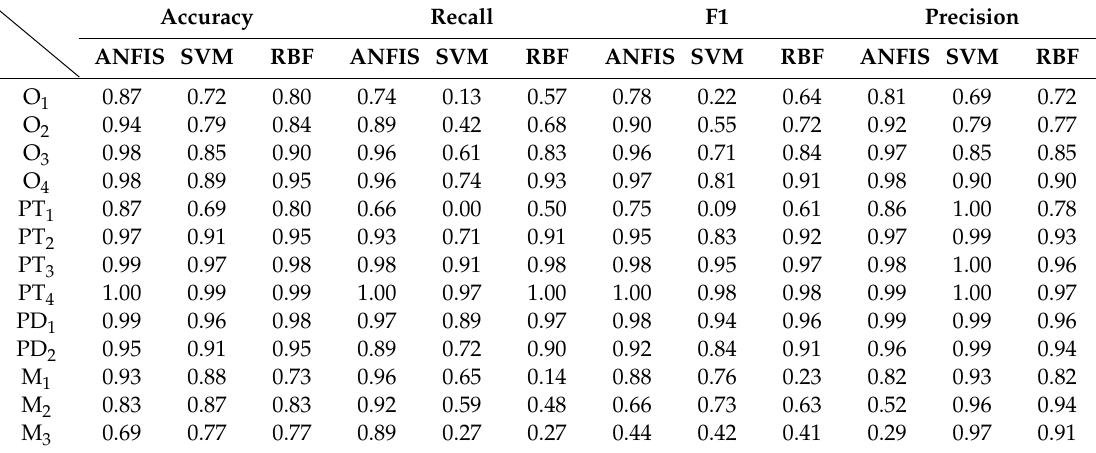
Table 5. Root mean square error (RMSE) calculated for the ANFIS training stage.